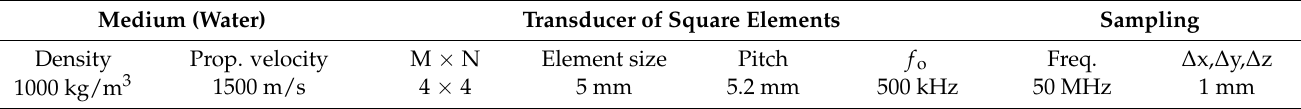
Table 1. Parameters used for acoustic field simulations.